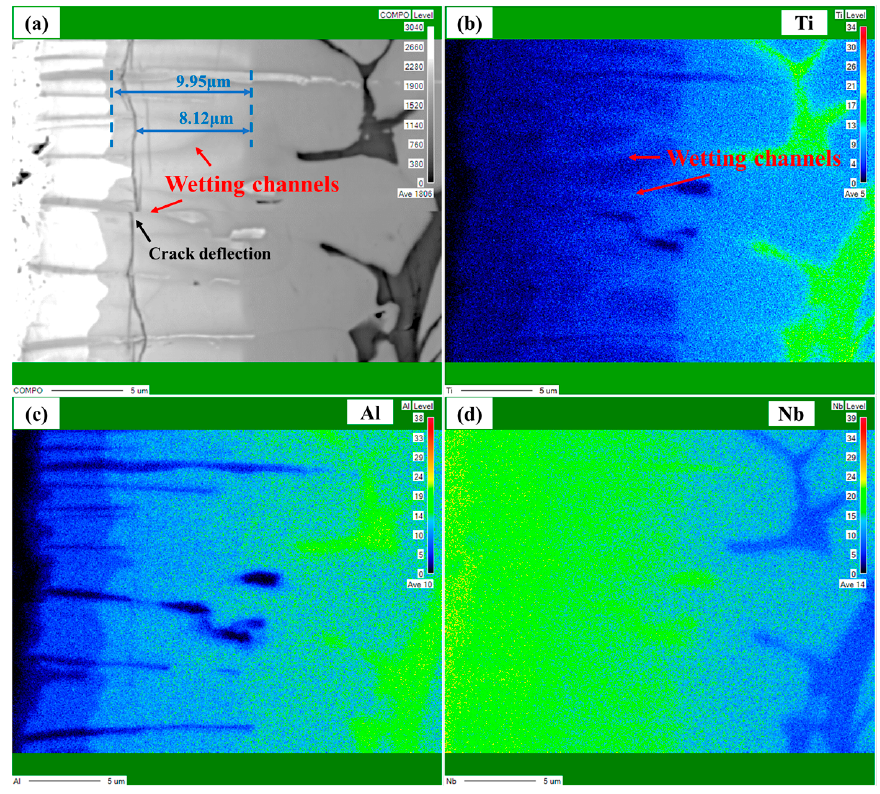
Figure 9. The cross-sectional microstructural analysis of the Nb container/TiAl melt interface for 0.5 h holding by EPMA: ( a ) EPMA-BSE image, ( b – d ) the spectrum mapping of Ti, Al, Nb in ( a ).